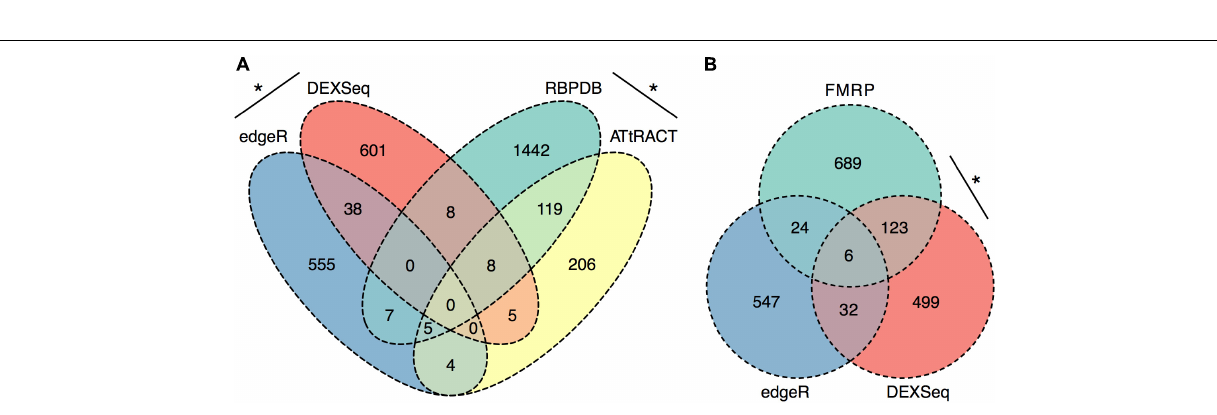
FIGURE 5 | Synapse-Specific DEU is enriched in RNABP targets. Ethanol sensitization altered synaptic exon usage for targets of RNA binding proteins. Ethanol sensitization did not enrich gene expression or differential exon usage (A) of RNA binding proteins at synapses. Synaptic DEU but not DGE were enriched for targets of FMRP following ethanol sensitization (B) ( ∗ p < 0.05, Fisher’s exact